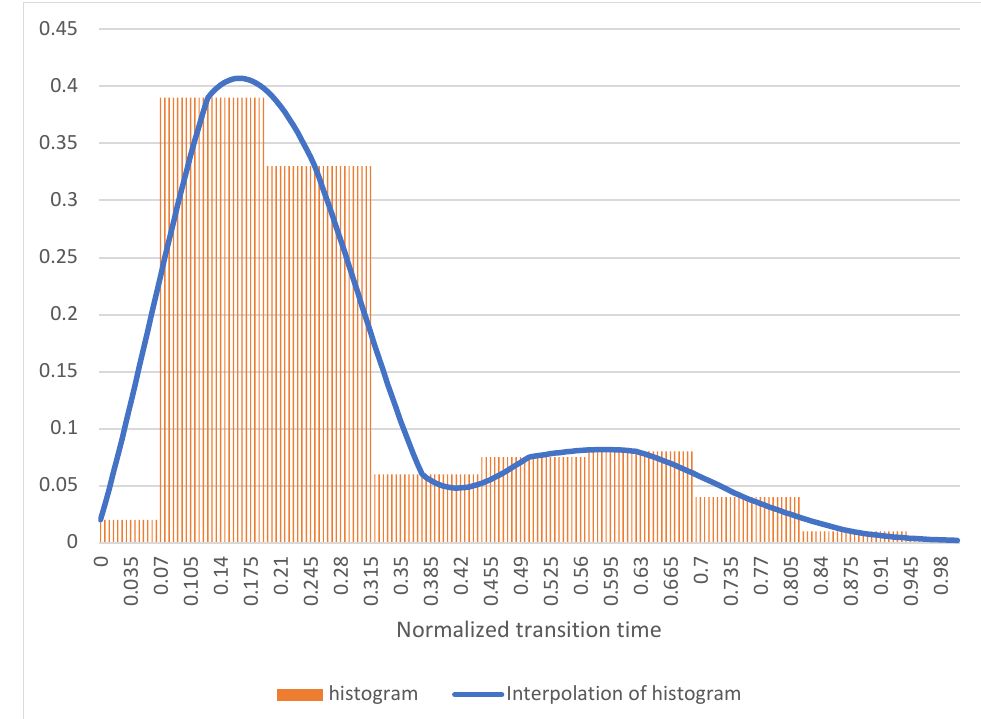
Figure 10. Interpolated values of normalized histogram h .